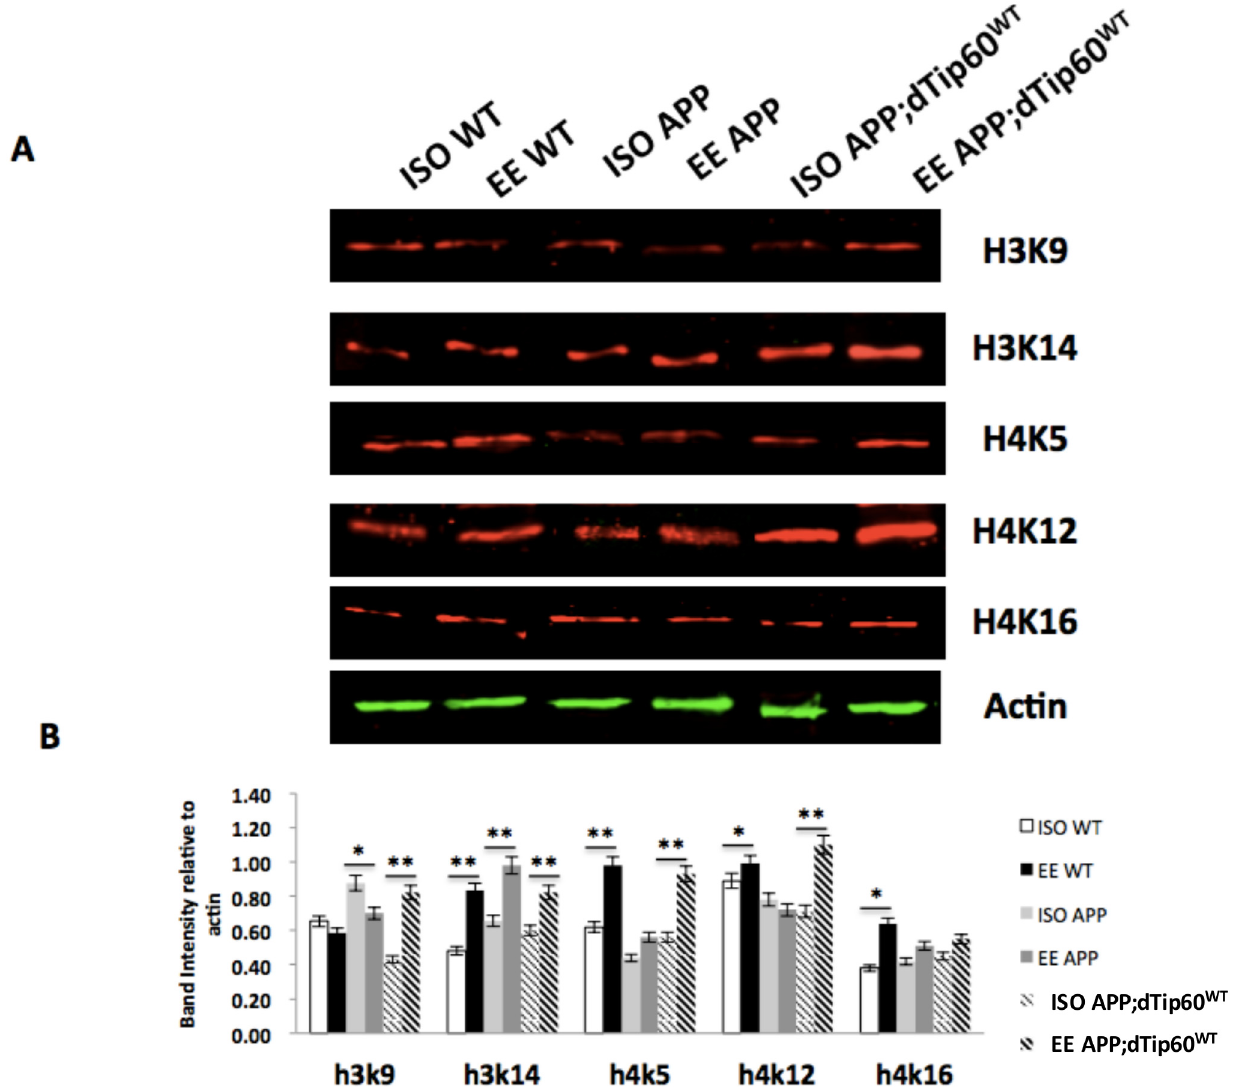
Fig 4. Restoration of H4K5 and H4K12 acetylation levels in response to EE requires Tip60 HAT action in APP flies. The indicated transgene was expressed in the fly MB using GFP;;OK107-Gal4 driver. Expression of human APP in MB results no significant acetylation change in response to EE, while increased Tip60 HAT activity restores such response in acetylation of H4K5 and H4K12. (A) Representative immunoblot showing histone acetylation in WT, APP and APP;dTip60 WT flies under ISO and EE conditions. (B) Quantification of (A). Independent (unpaired) Student t-test was used to determine statistical significance between EE versus ISO conditions within the same genotype for each histone acetyl marks. Each blot was repeated at least three times. Each histone sample was extracted from fly heads. Proteins were extracted from at least two independent pooled tissue samples (30 heads for each extract). Each sample was run at least three times for statistic analysis. ** P < 0.01, * P < 0.05. Error bars indicate